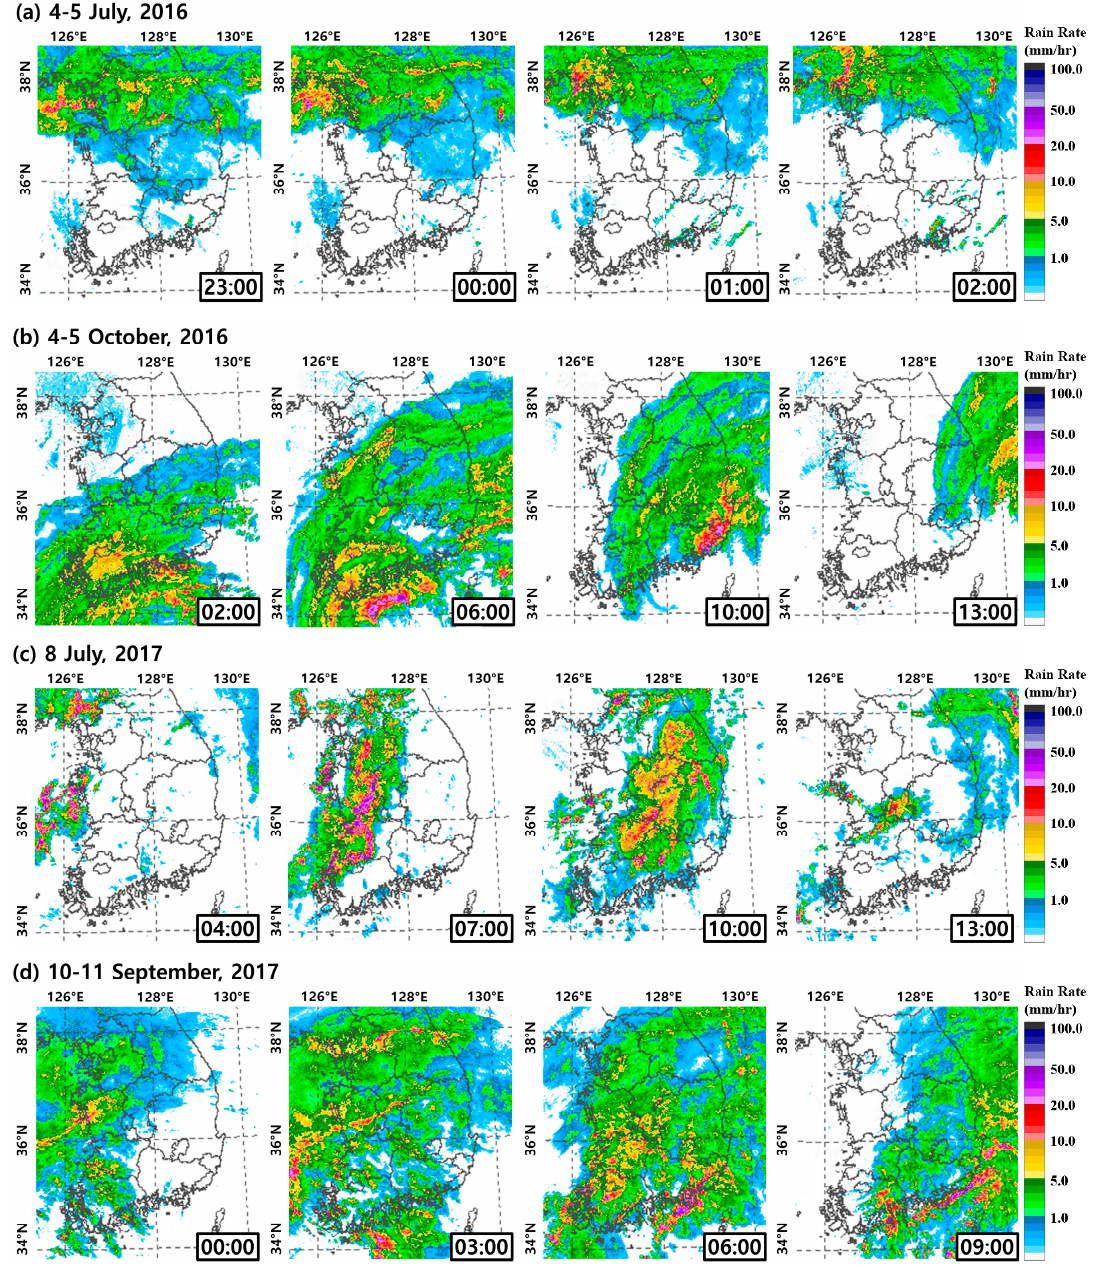
Figure 2. Radar images of the selected four major storm events that occurred in 2016 and 2017.